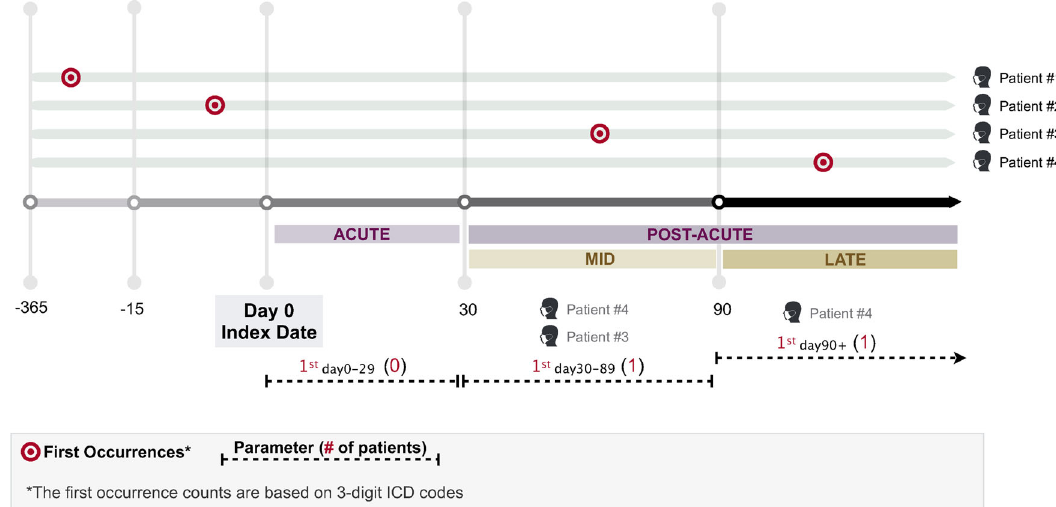
Fig. 6 Study schematic of diagnosis code recording periods relative to the de fi ned index date. Diagnosis codes in the post-acute period are de fi ned as diagnosis codes recorded 30 days after initial infection. First occurrence diagnosis codes were de fi ned as diagnosis codes which were not observed up to 365 days prior to the infection